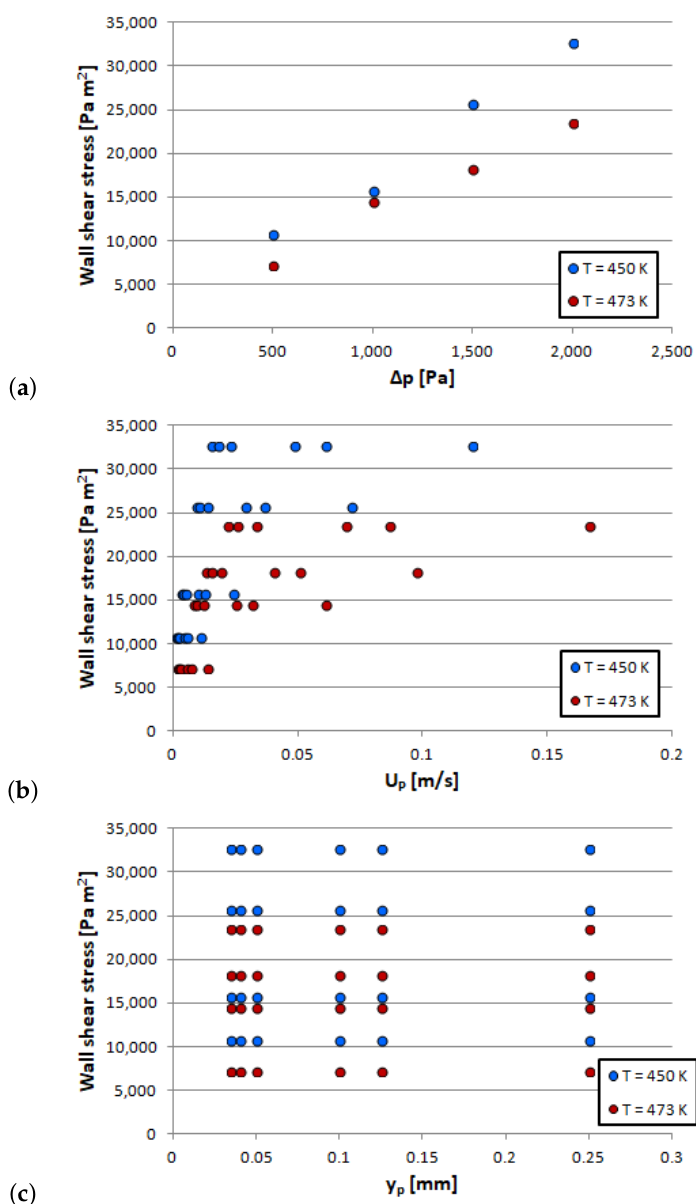
Figure 5. Flow on a representative domain near the wall, results: ( a ) ∆ p vs wall shear stress; ( b ) U P vs wall shear stress; and ( c ) y P vs wall shear